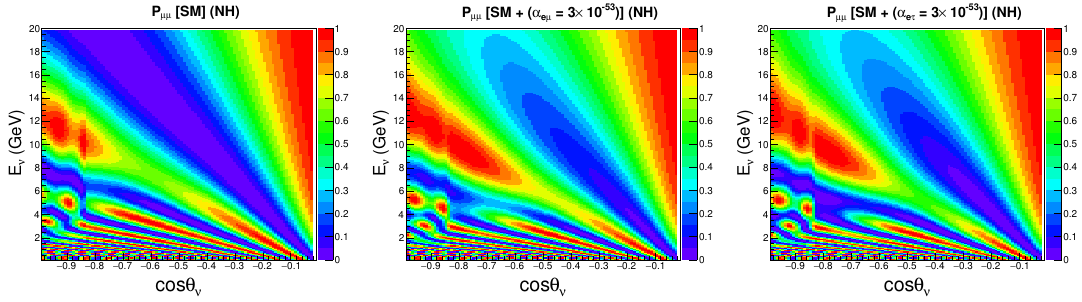
Figure 7 . The oscillograms for (cid:23) (cid:22) ! (cid:23) (cid:22) channel in E (cid:23) , cos (cid:18) (cid:23) plane for three di(cid:11)erent scenarios: i) (cid:11) e(cid:22) = (cid:11) e(cid:28) = 0 (the SM case, left panel), ii) (cid:11) e(cid:22) = 3 (cid:2) 10 (cid:0) 53 , (cid:11) e(cid:28) = 0 (middle panel), and iii) (cid:11) e(cid:22) = 0, (cid:11) e(cid:28) = 3 (cid:2) 10 (cid:0) 53 (right panel). Here, in all the panels, we assume NH. baselines as compared to the SM case. This feature gets re(cid:13)ected in the middle and right panels of (cid:12)gure 4 for non-zero (cid:11) and (cid:11) respectively. Figure 4 also depicts that e(cid:22) e(cid:28)